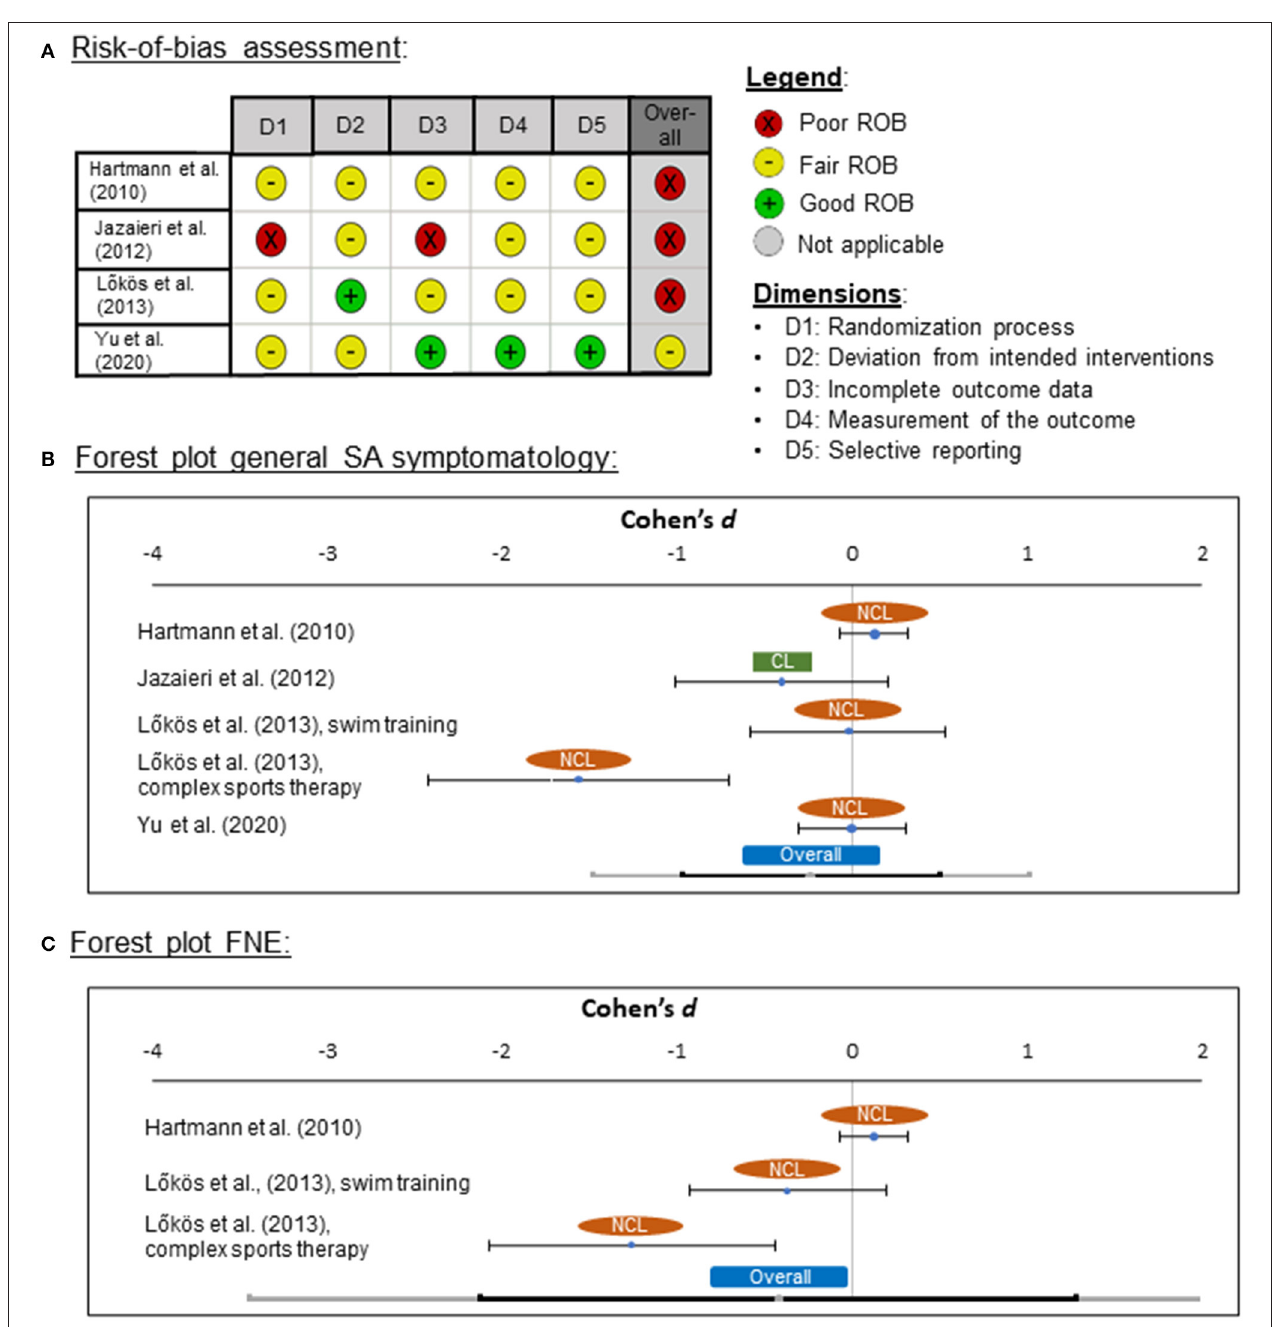
FIGURE 2 | (A) Risk-of-bias (ROB) quality ratings for the randomized-controlled trials (RCT), (B) forest plot for general social anxiety (SA) symptomatology for clinical (CL) and non-clinical (NCL) samples, and (C) for fear of negative evaluation (FNE). ROB was assessed by means of the “Quality Assessment Tool of Controlled Intervention Studies” from the National Heart, Lung, and Blood Institute (2019). Negative effect sizes indicate that symptomatology was lower in the PA treatment than in the control